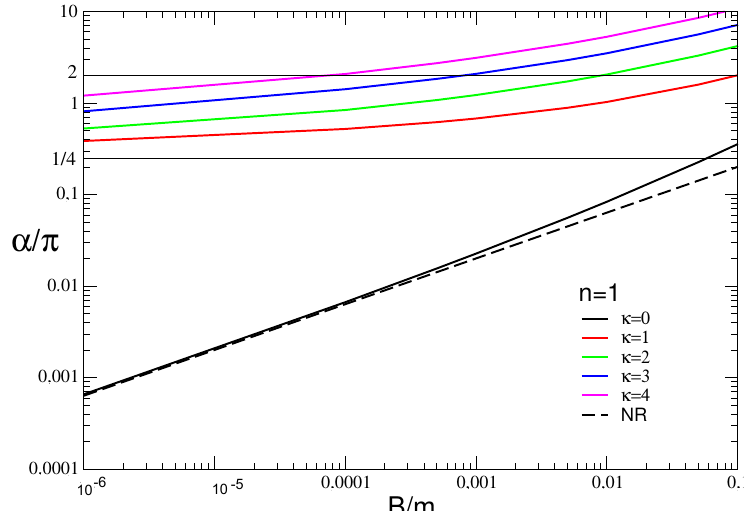
Figure 1. Spectrum in the Wick–Cutkosky model of the lowest coupling constants α ( B ) / π vs. κ for n = 1. The black solid line corresponds to κ = 0. The black dashed line is the non-relativistic solution. The colored solid lines correspond to κ = 1 ÷ 4. The horizontal line at α / π = 1/4 corresponds to the minimal coupling constant for which the abnormal solutions exist. (Adapted from [1]).